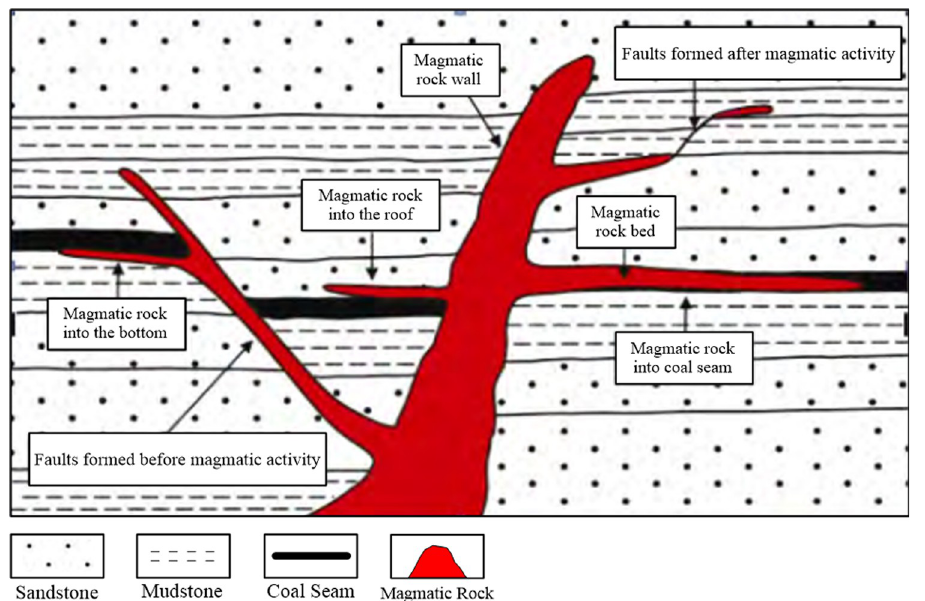
Fig 1. Schematic diagram of magmatic rock intruding into coal